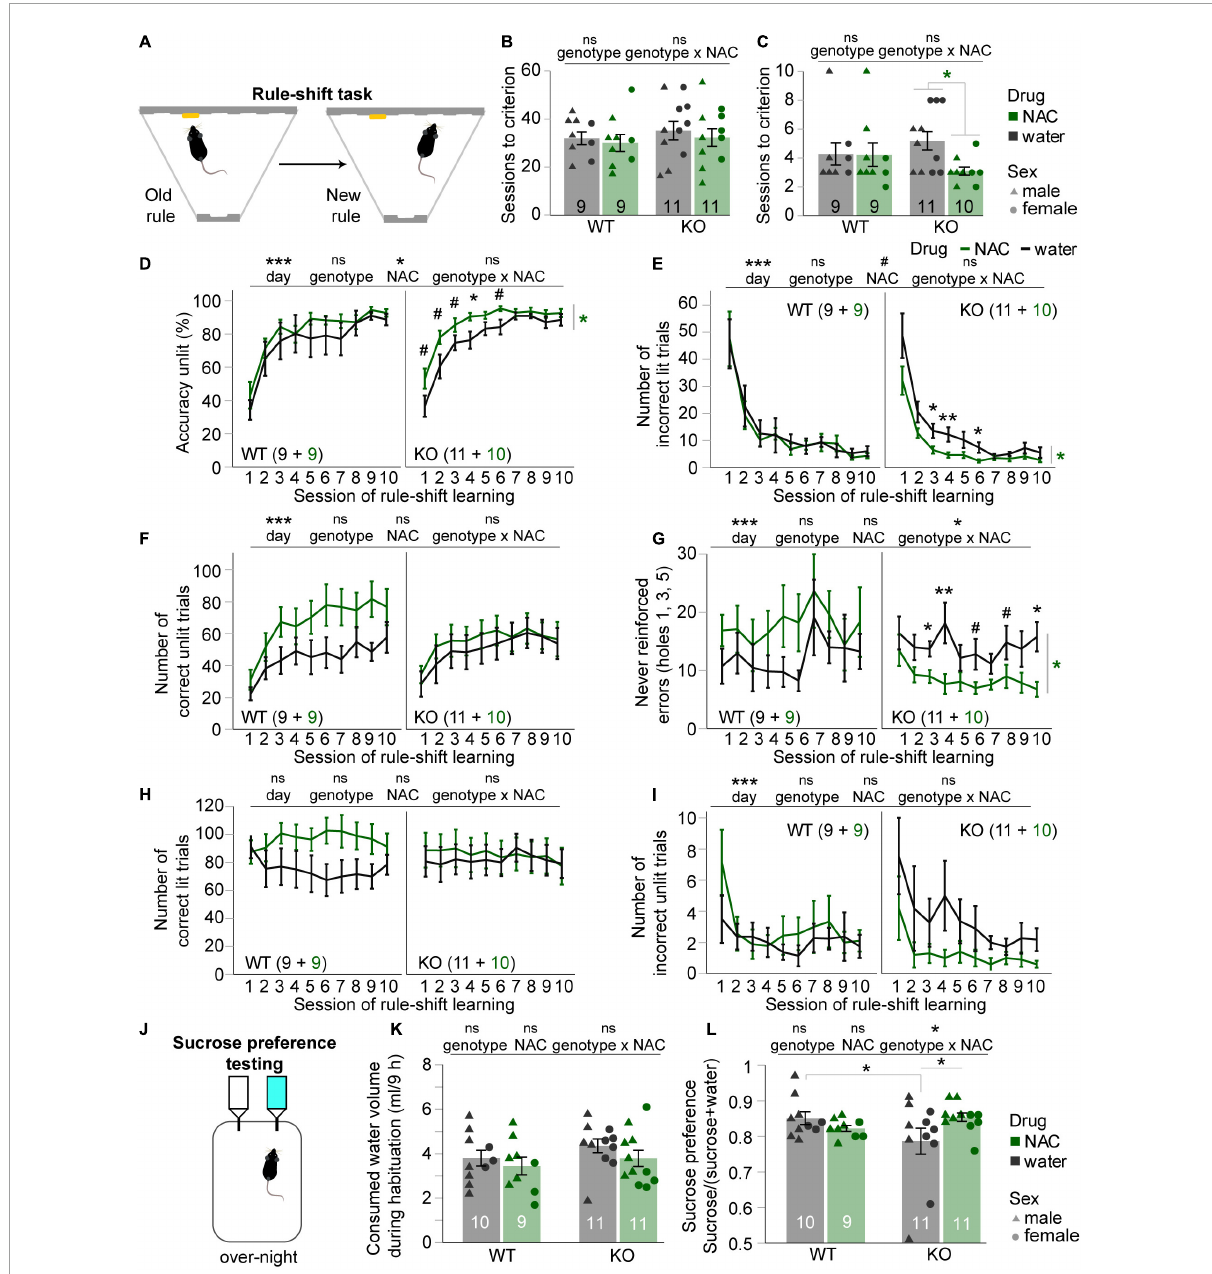
FIGURE3 Chronic N-acetylcysteine treatment improves cognitive flexibility and sucrose preference (anhedonia) in cyclin-D2 knockout mice. (A) Illustration of the first, cue-related and the second, spatial rule animals had to acquire in the operant rule-shift task. (B,C) Number of sessions needed after the rule-shift to achieve the training criterion of ≥ 70% accuracy (B) or accuracy unlit (C) in two consecutive sessions; data of individual animals is shown in addition, coded by treatment and sex. Results of MWU-tests between treatments groups within genotype are indicated where they were significant. Genotype-related main effects of univariate ANOVA are shown above each panel. (D–I) Averages of the performance parameters indicated on the y-axes in the 10 rule-shift learning sessions shown for NAC-treated (green) and untreated (black) mice of the genotype indicated in the bottom left or top right of each subpanel, also displaying n-numbers. Main effects and genotype-NAC interactions from overall RM-ANOVA across the first six sessions (where a performance improvement can be assumed) are indicated above panels. Significant effects of drug treatment from RM-ANOVAs within each genotype are indicated on the right of each sub-panel where significant; for these cases, significant pairwise post-hoc comparisons within each session are indicated directly above the data. (J) Illustration of task. (K) Consumed volume of liquid during the habituation session, approx. 12 h after NAC treatment had ceased and immediately before sucrose-preference testing was started. (L) Sucrose preference score achieved by each subgroup indicated on the x -axis (genotype) and by color (NAC, green; water, black); data of individual animals is shown in addition, coded by treatment and sex. Significant drug-genotype interaction found in overall univariate ANOVA is indicated on top (no significant main effects of drug or genotype were found). Šidák post-hoc comparisons are indicated directly above data, where significant. * p < 0.05. Error bars, S.E.M. # p < 0.1; * p < 0.05; *** p < 0.001. Error bars,